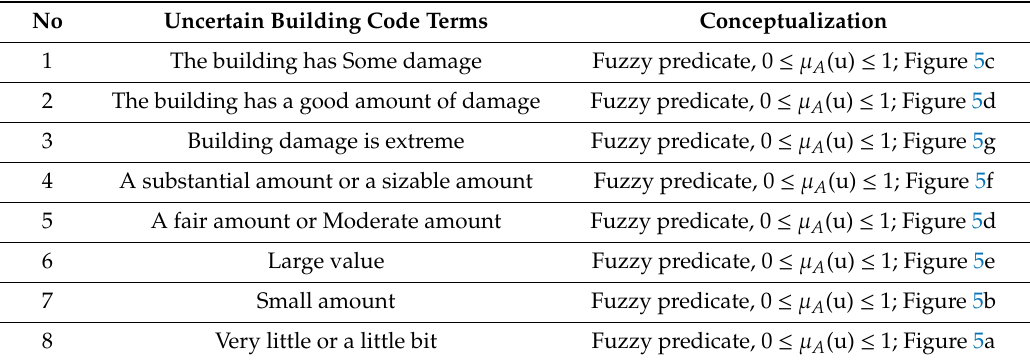
Figure 6. The concept of fuzzy transformation of building damages. ( a ) Very little damage; ( b ) Small damage; ( c ) Some damage; ( d ) Moderate damage; ( e ) Large damage; ( f ) Substantial damage; ( g ) Extreme damage. Table 3. Common ambiguous terms in building Table 2. Common ambiguous terms in building regulations.